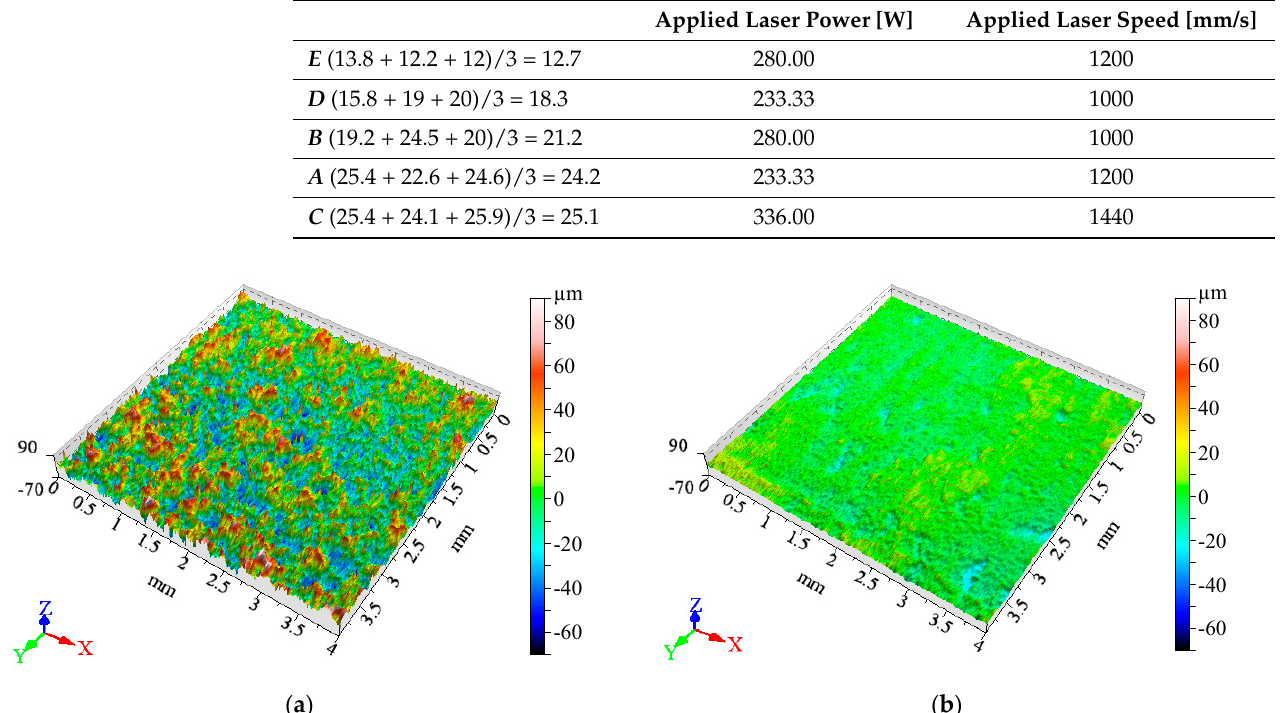
Figure 16. 3D roughness images: ( a ) before burnishing and ( b ) after burnishing on the specimen E5 − 1A. Table 15. Improvement ratio indices for cylinders manufactured with different technologies (parameter setup, referring to Table 1) for R a , R z , and R q ; furthermore, S a , S z , and S q. Code of Parameter